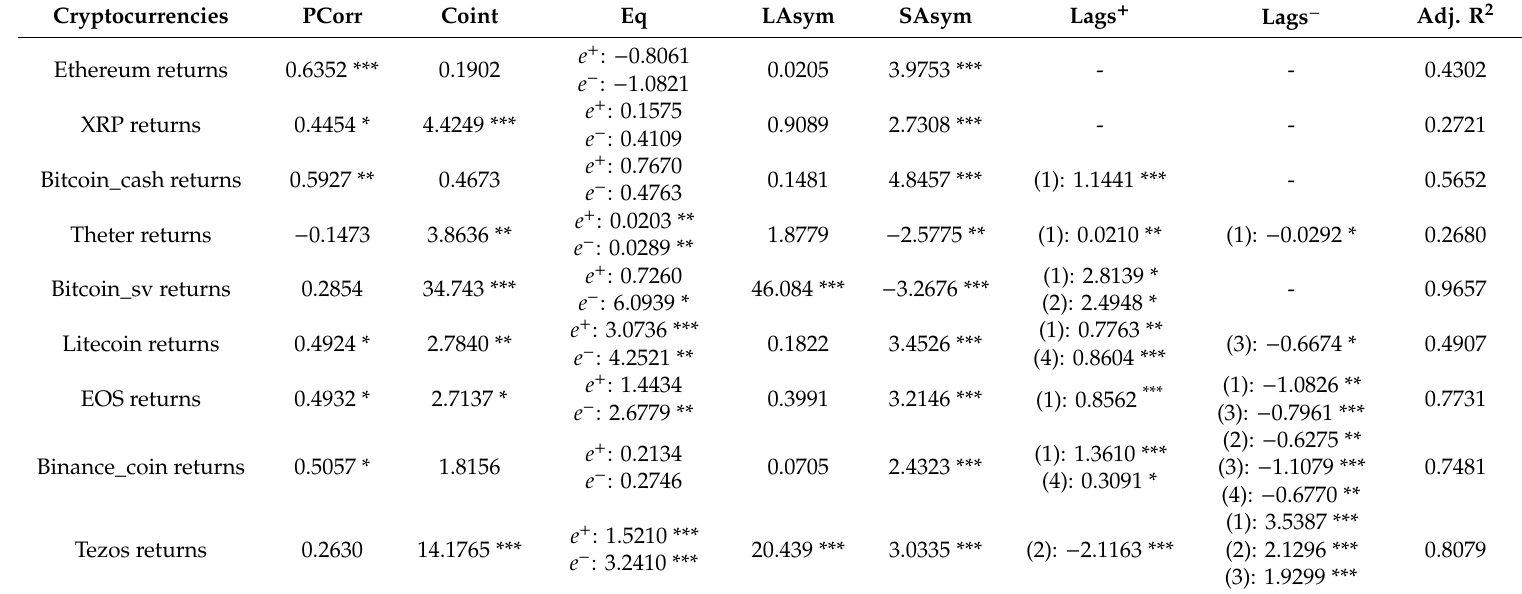
Table 5. Regression results of nonlinear ARDL models: asymmetry and cointegration tests between Bitcoin returns and the rest of relevant cryptocurrencies’ returns: monthly frequency.